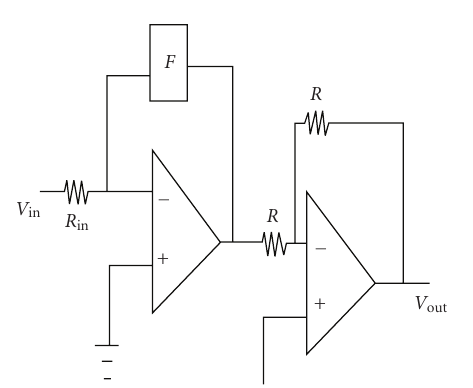
Figure 4: Passive realization of the fractance device.